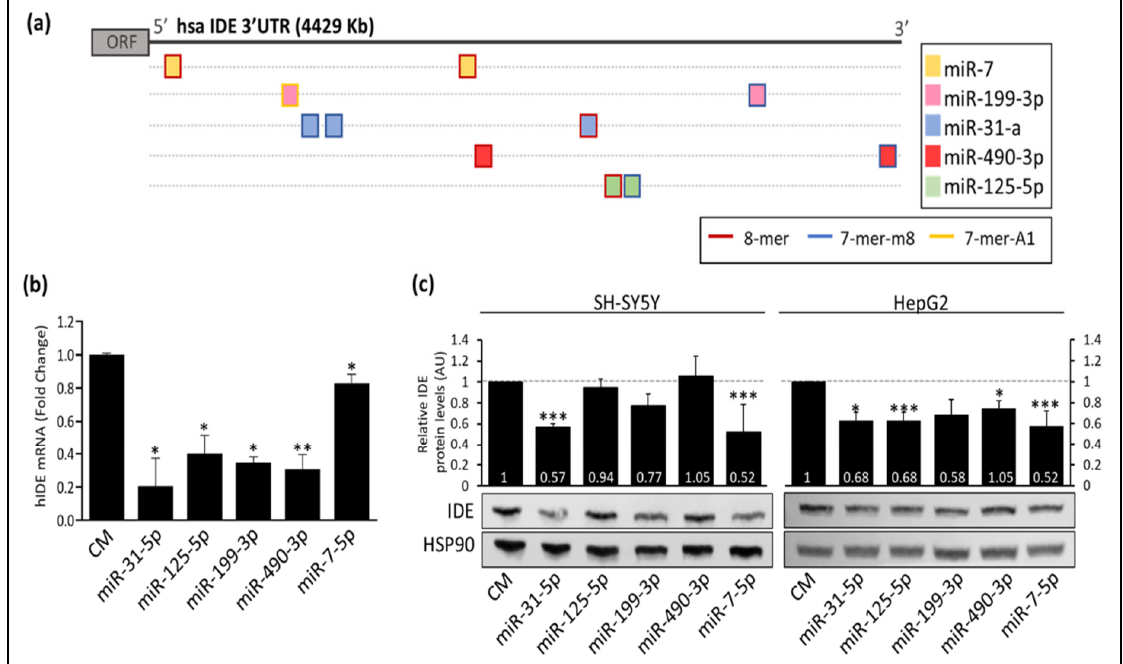
Figure 2. The expression of IDE is regulated by multiple miRNAs in vitro. ( a ) Representation of predicted target miRNAs sites for hIDE 3 ′ UTR. The square flange color indicates the type of binding site. The color inside the square shows the miRNA targets of that region ( b ) qPCR of IDE in SH cells. ( c ) Representative Western blot analysis of IDE in SH and HepG2 cells transfected with miR ‐ 31 ‐ 5p, miR ‐ 125 ‐ 5p, miR ‐ 199a ‐ 3p and miR ‐ 7 ‐ 5p. (Top) Relative hIDE levels corresponding to the means ± SEM from three independent experiments. *, p < 0.05; **, p < 0.01; ***, p < 0.001 (significantly different from cells transfected with the CM).